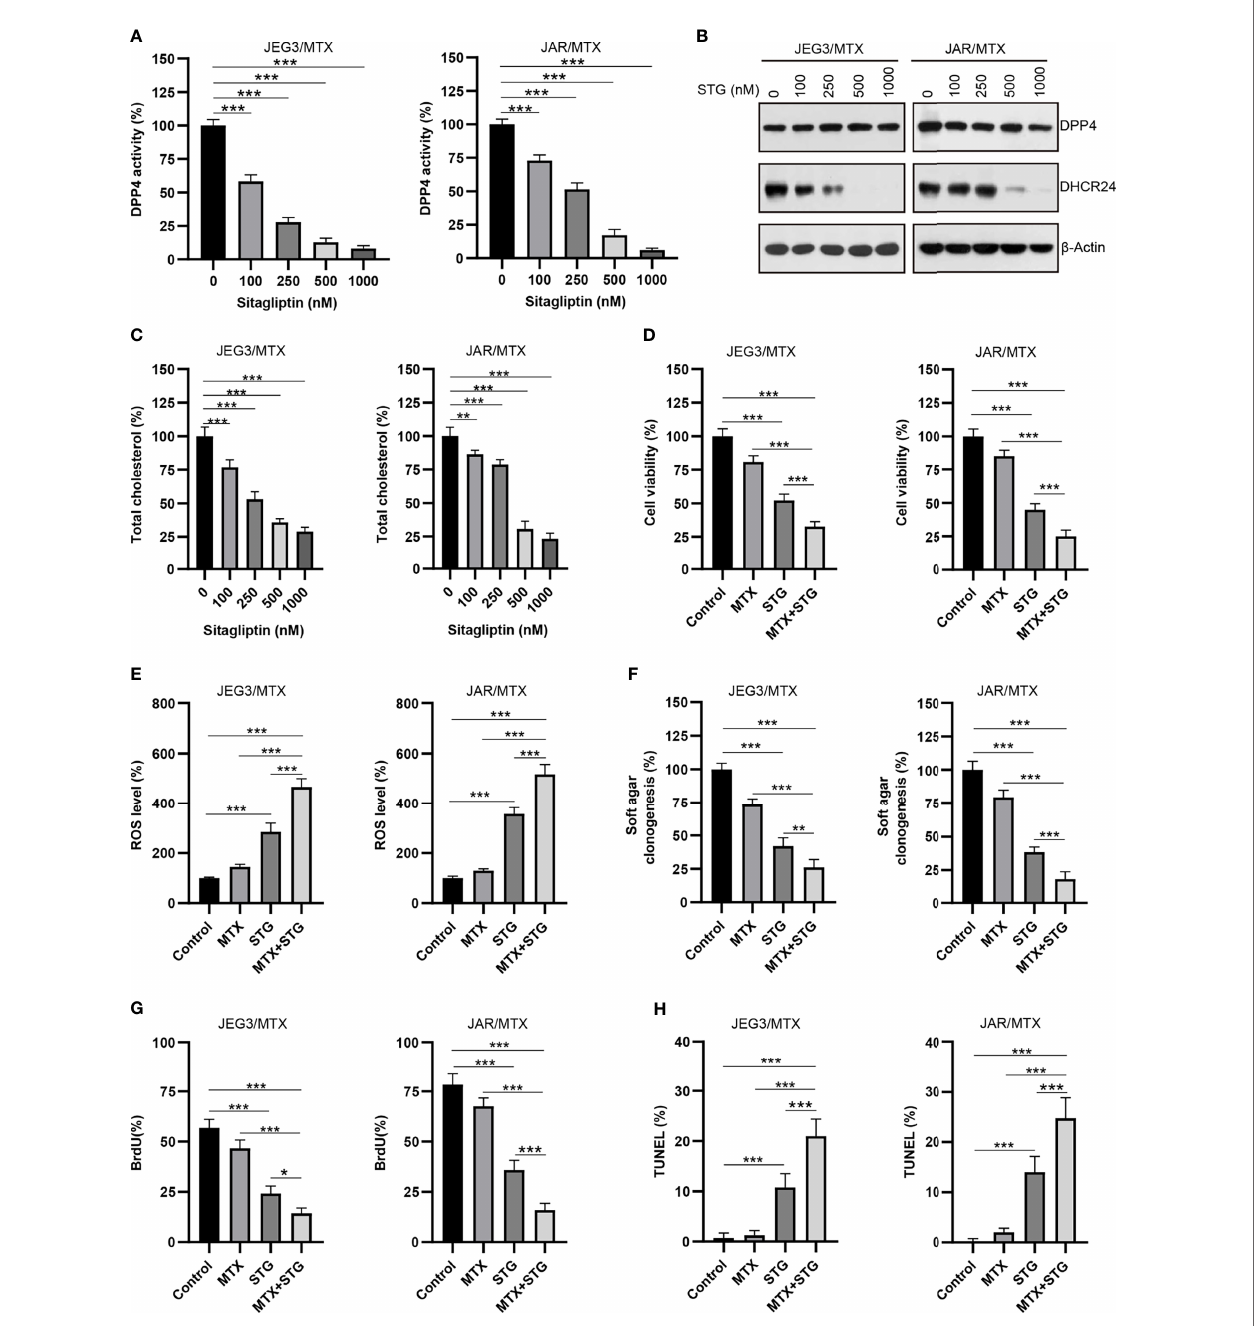
FIGURE 7 | The effect of DPP4 inhibitor sitagliptin on DHCR24 expression, cellular cholesterol level and MTX chemosensitivity in MTX-resistant GTN sublines. (A) Dose effect of sitagliptin on DPP4 enzymatic activity in JEG3/MTX and JAR/MTX cells. Cells were treated with vehicle control (DMSO) or escalating doses of sitagliptin for 24 hours. The DPP4 enzymatic activity in vehicle control was regarded as 100%. n=4, ***P<0.001. (B) Dose effect of sitagliptin (STG) on DHCR24 expression in JEG3/MTX and JAR/MTX cells. (C) Dose effect of sitagliptin on cellular cholesterol level in JEG3/MTX and JAR/MTX cells. The cellular cholesterol level in vehicle control was regarded as 100%. n=4, **P<0.01; ***P<0.001. (D) Sitagliptin alone or combined with MTX reduced cell viability in JEG3/MTX and JAR/MTX cells. Cells were treated with sitagliptin alone (1 m M) or in combination with MTX (10 m M) for 96 hours. The cell viability in vehicle control was regarded as 100%. n=4, ***P<0.001. (E) Sitagliptin alone or combined with MTX increased ROS accumulation in JEG3/MTX and JAR/MTX cells. The ROS level in vehicle control without MTX treatment was regarded as 100%. n=4, ***P<0.001. (F) Sitagliptin alone or combined with MTX impaired clonogenesis in JEG3/MTX and JAR/MTX cells. The colony formation in vehicle control was regarded as 100%. n=4, **P<0.01; ***P<0.001. (G) Sitagliptin alone or combined with MTX reduced BrdU incorporation in JEG3/MTX and JAR/MTX cells. n=4, *P<0.05; ***P<0.001. (H) Sitagliptin alone or combined with MTX increased TUNEL labeling in JEG3/ MTX and JAR/MTX cells. n=4,